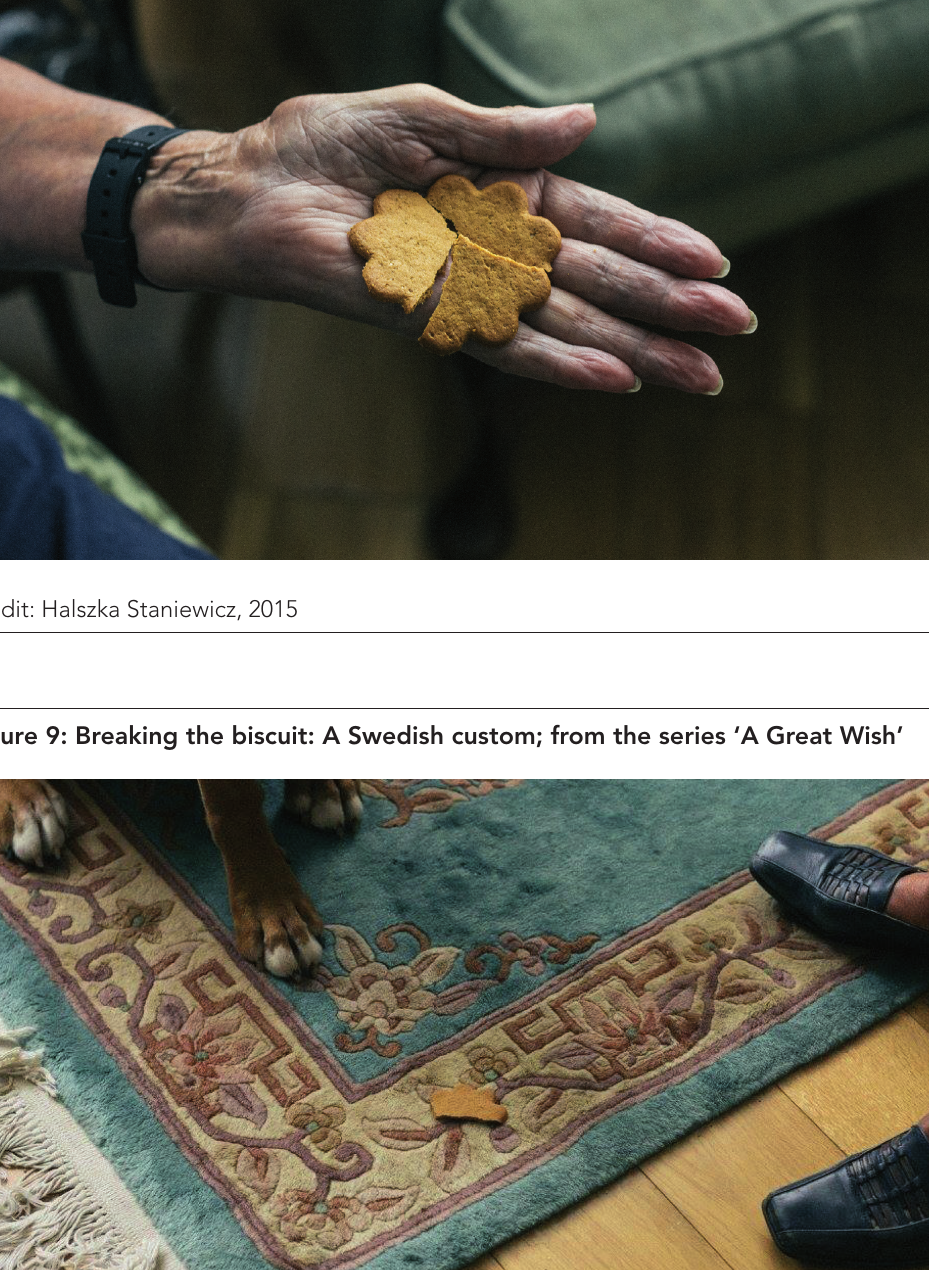
Credit: Halszka Staniewicz,